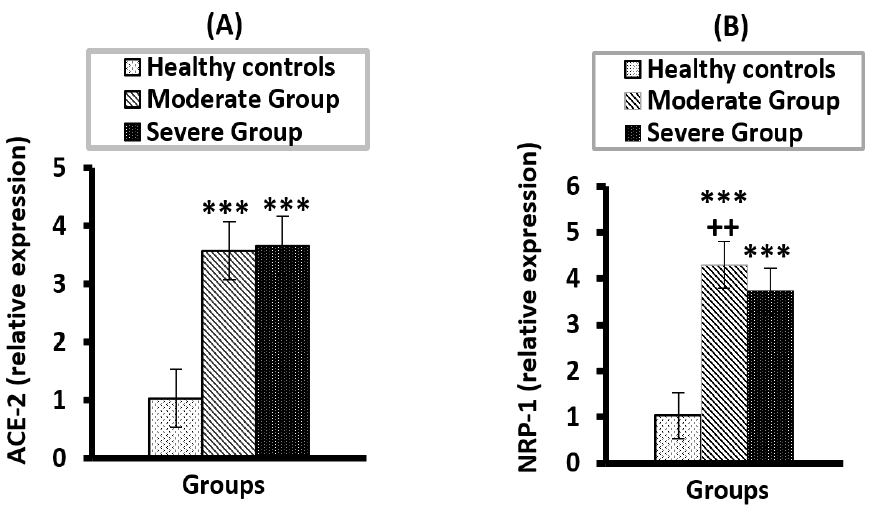
Figure 3. The mRNA expression of ACE-2 ( A ) and NRP-1 ( B ) in moderate and severe COVID-19 groups compared to healthy control. *** significant compared to heathy control at p < 0.001; ++ significant compared to severe group at p < 0.01.